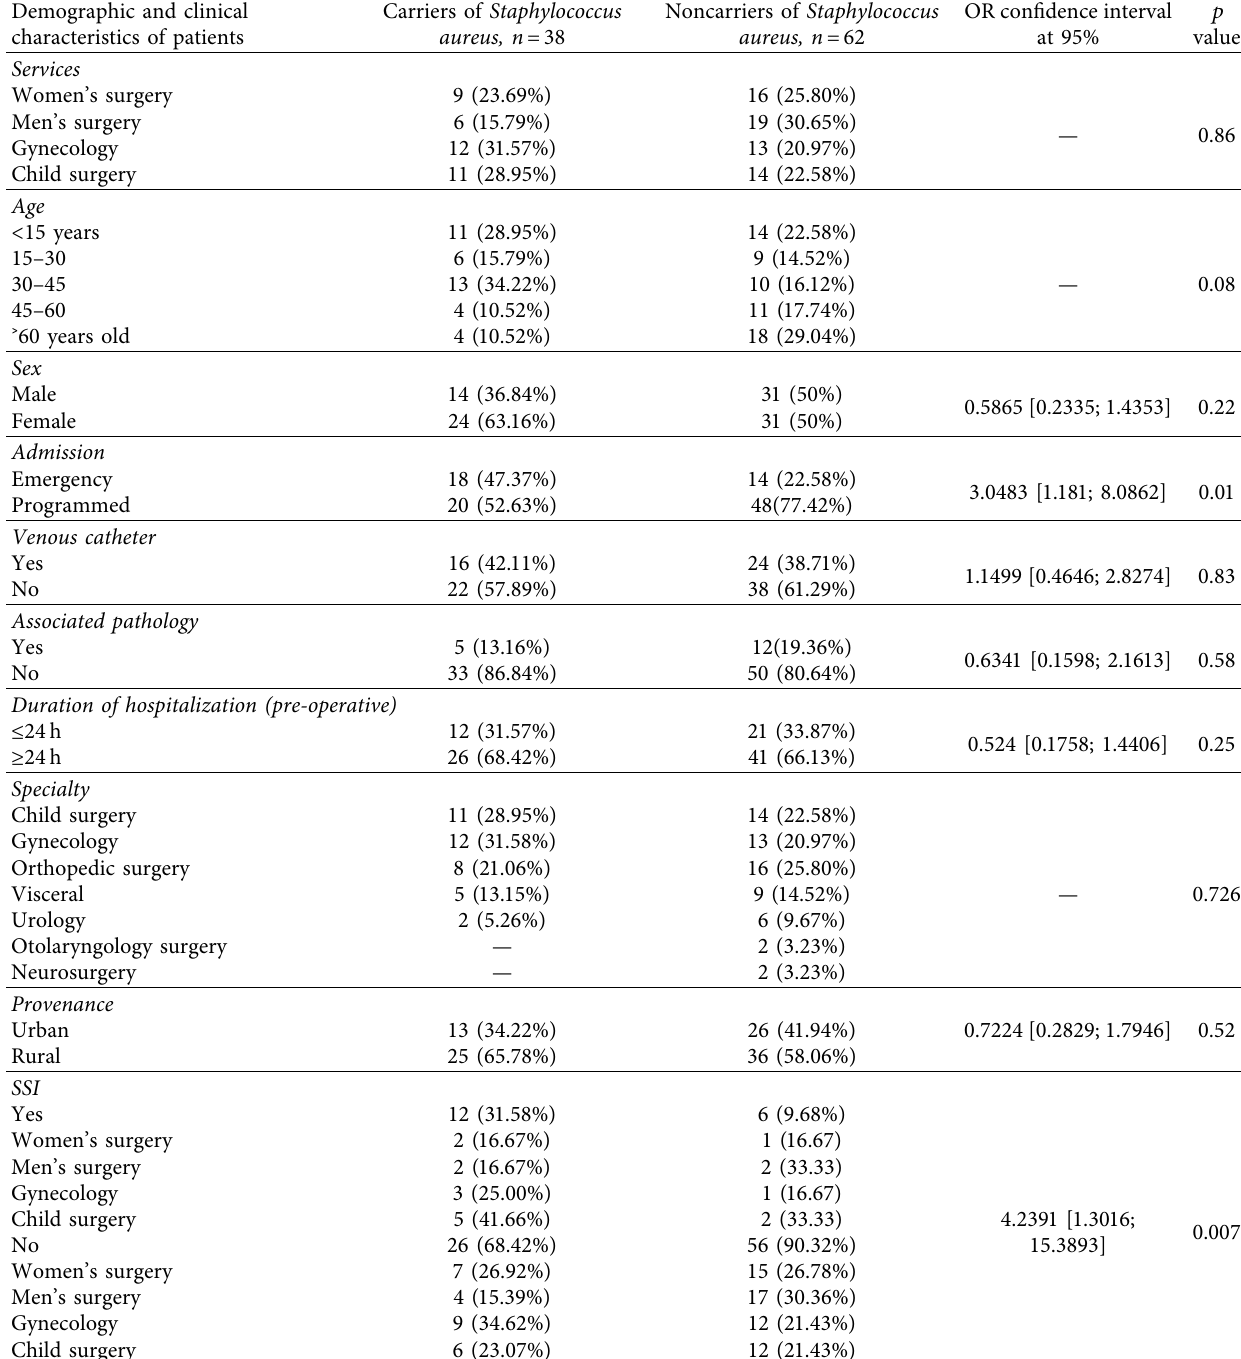
Table 1: Demographic and clinical characteristics of patients by nasal carriage status of Staphylococcus aureus ( N � 100). Demographic and